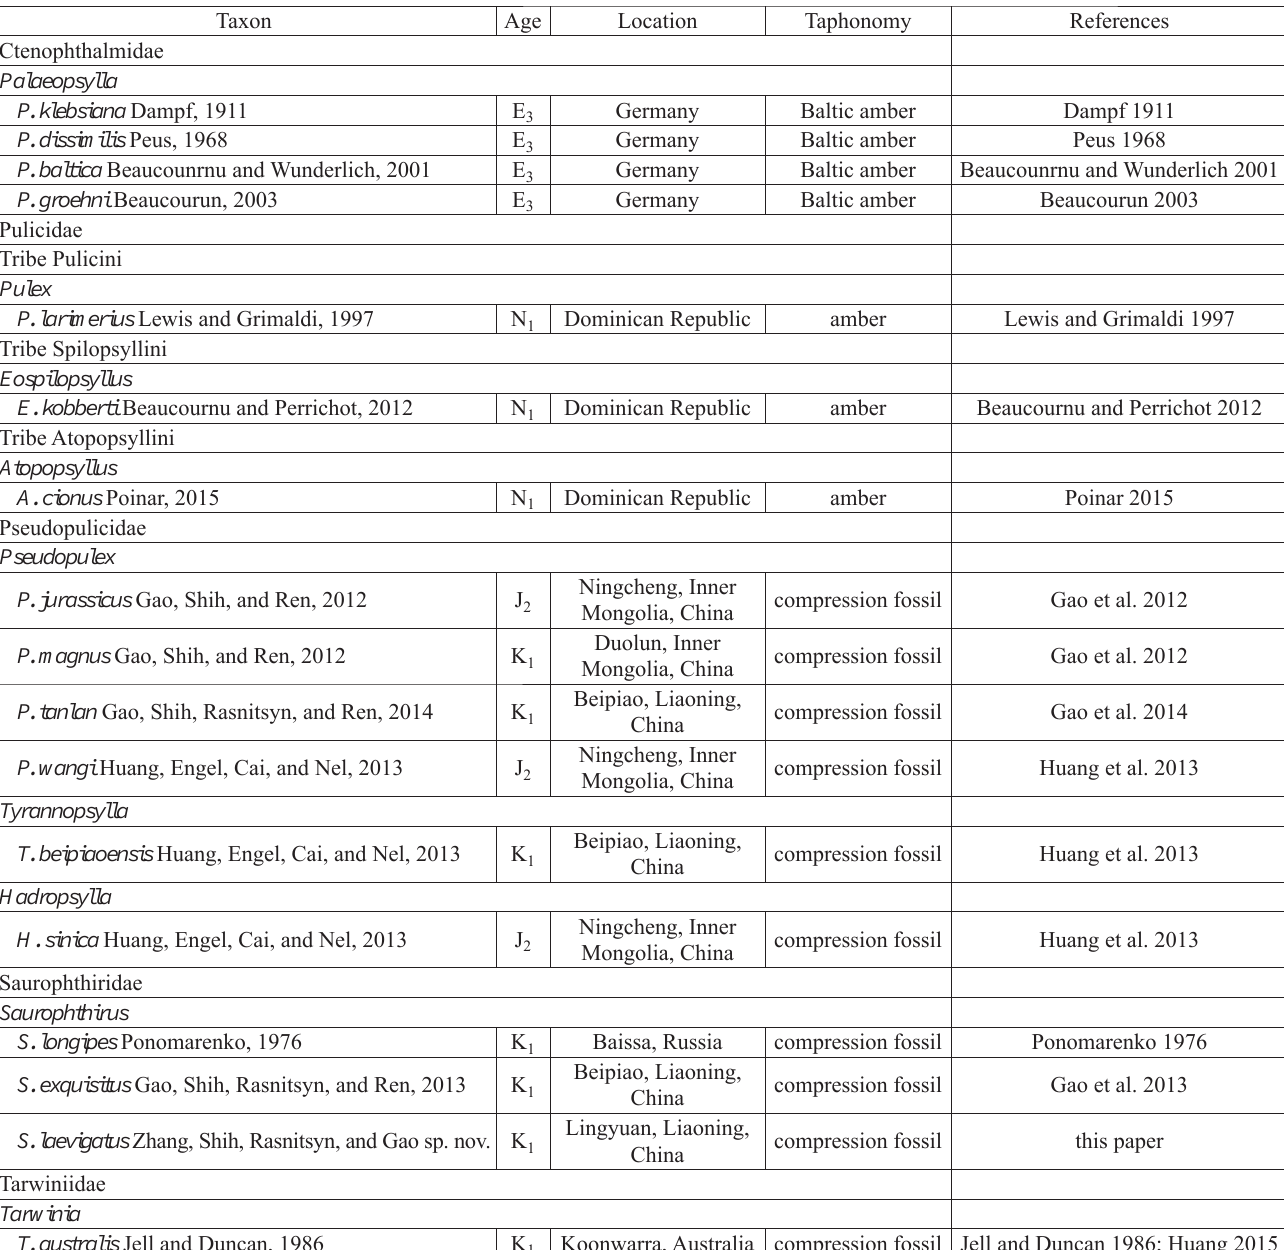
Table 1. Fossil records of Siphonaptera. Abbreviations: E 3 , late Eocene (Priabonian); J 2 , Middle Jurassic; K 1 , Early Cretaceous; N 1 , Miocene.